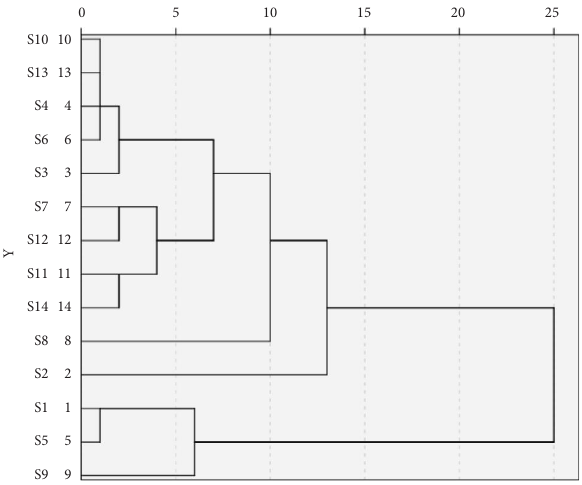
Figure 6: HCA dendrogram of fourteen samples. Table 9: Eigen values and contribution rate of 14